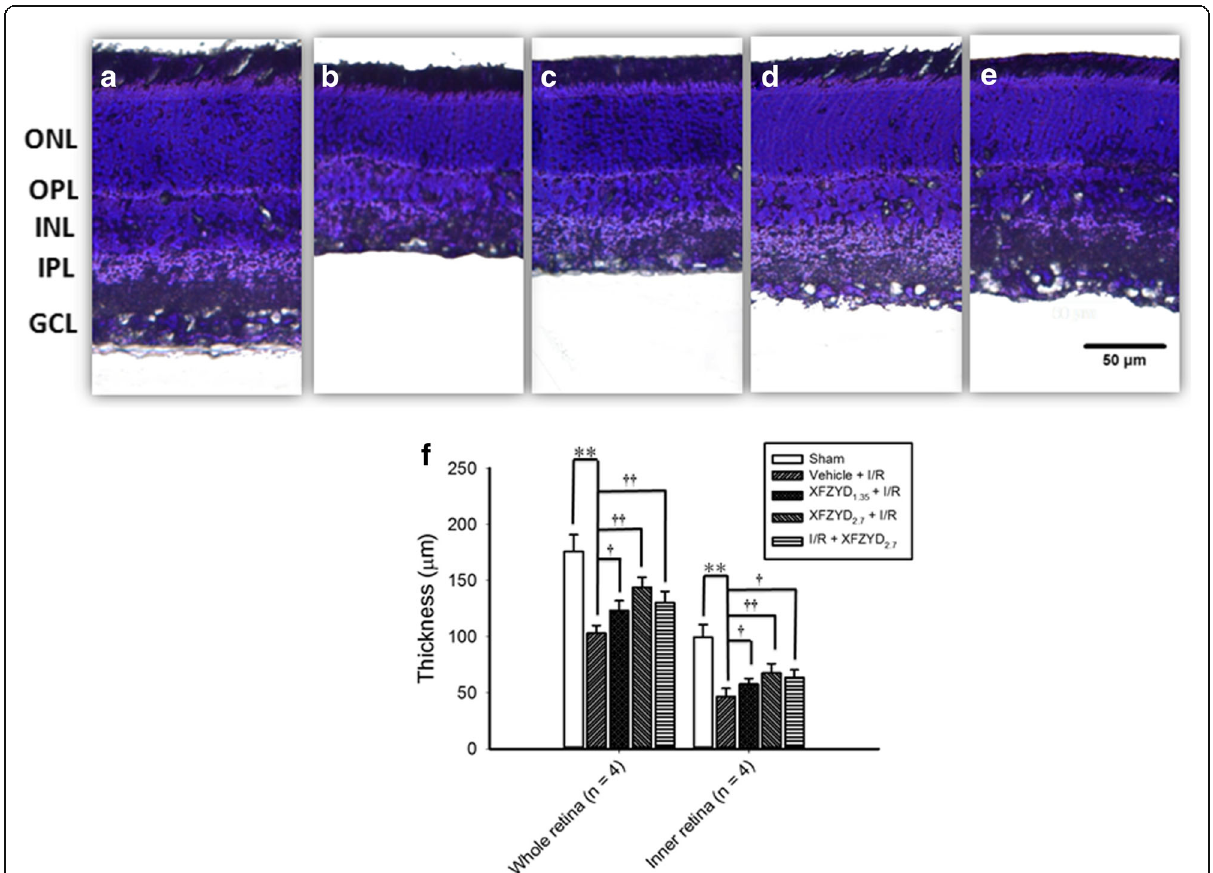
Fig. 3 Cresyl violet staining: analysis of the thickness of various retinal layers. Sectioned retinal pieces of the identical eccentricity are shown. a is from a retina subjected to the sham procedure (Sham). b is from a retina that was given ischemia plus reperfusion (I/R) and preischemia administration of vehicle. c , d , e are sections from retinas that have received ischemia plus reperfusion and preischemia administration of 1.35 g/kg/day XFZYD (c, XFZYD 1.35 + I/R), 2.7 g/kg/day XFZYD (d, XFZYD 2.7 + I/R) or postischemia administration with 2.7 g/kg/day XFZYD (e, I/R + XFZYD 2.7 ). The thickness of the different retinal layers from sectioned retinal pieces of the identical eccentricity is demonstrated. f The results indicate the mean values ± SD ( n = 4). ** indicates a significant difference ( p < 0.01) from the Sham retina. † or †† indicates a significant difference ( p < 0.05 or p < 0.01) from the Vehicle + I/R retina. Abbreviations: XFZYD, Xue-Fu-Zhu-Yu decoction; ONL, outer nuclear layer; OPL, outer plexiform layer; INL, inner nuclear layer; IPL, inner plexiform layer; GCL, ganglion cell layer. Scale bar = 50 μ